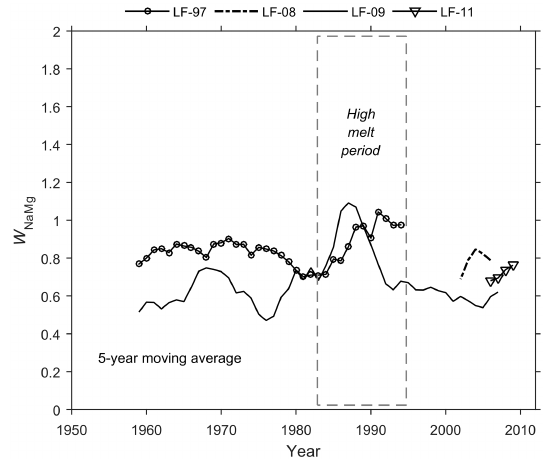
Figure 5. Melt index W NaMg calculated in the different Lomonosovfonna ice cores. The values correspond to 5-year mov- ing averages. The dashed lines indicates a high melting period dur- ing mid-80s to